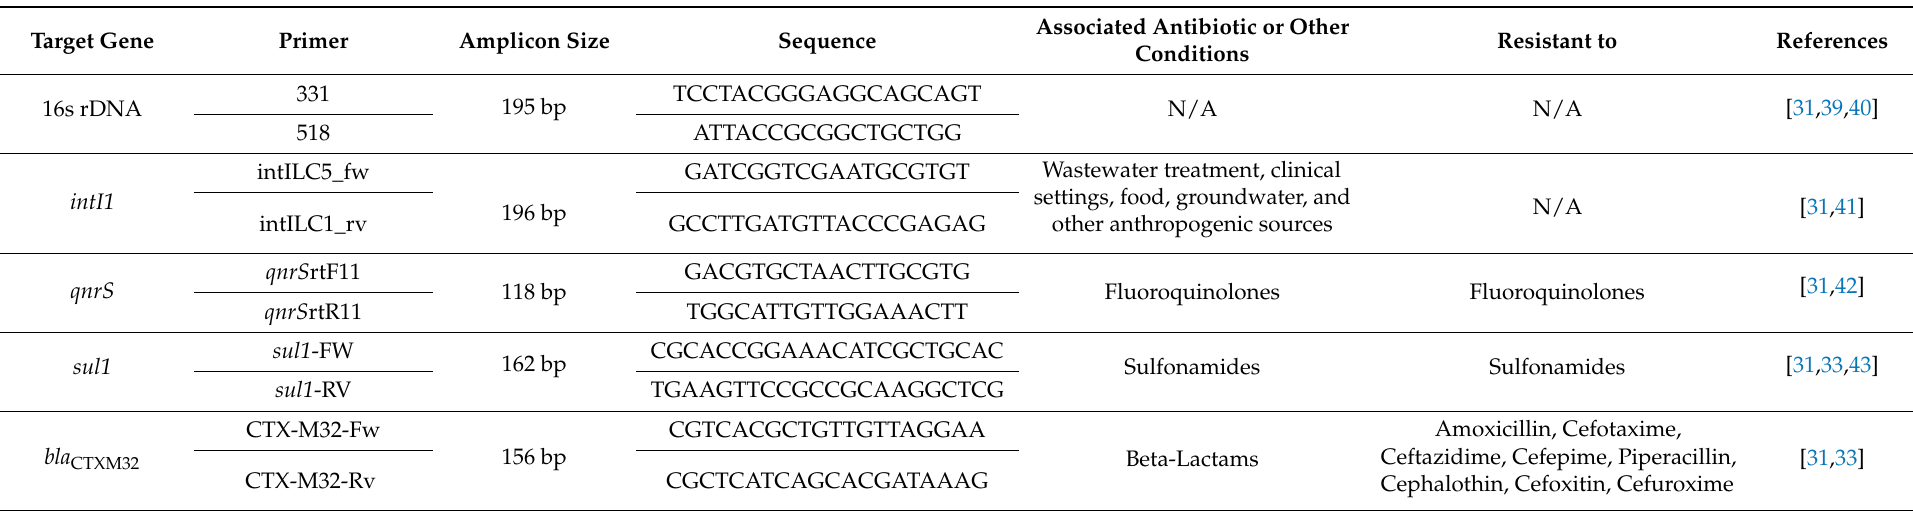
Table 1. Target genes, primers, amplicon size, and partial sequences used for PCR and qPCR detection of